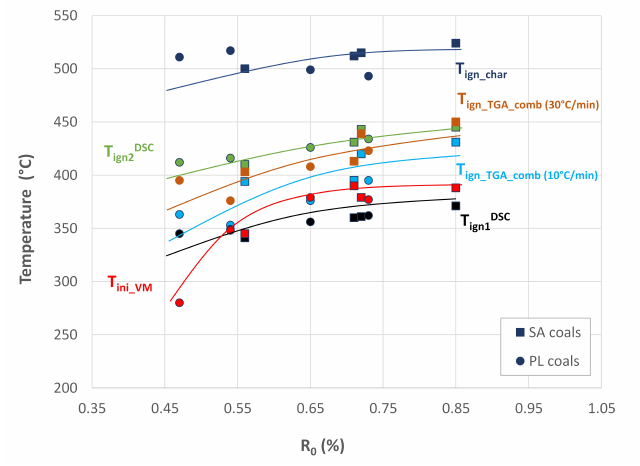
Figure 1. The effect of vitrinite reflectance ( R 0 ) on the TGA/DSC ignition temperature, T TGA